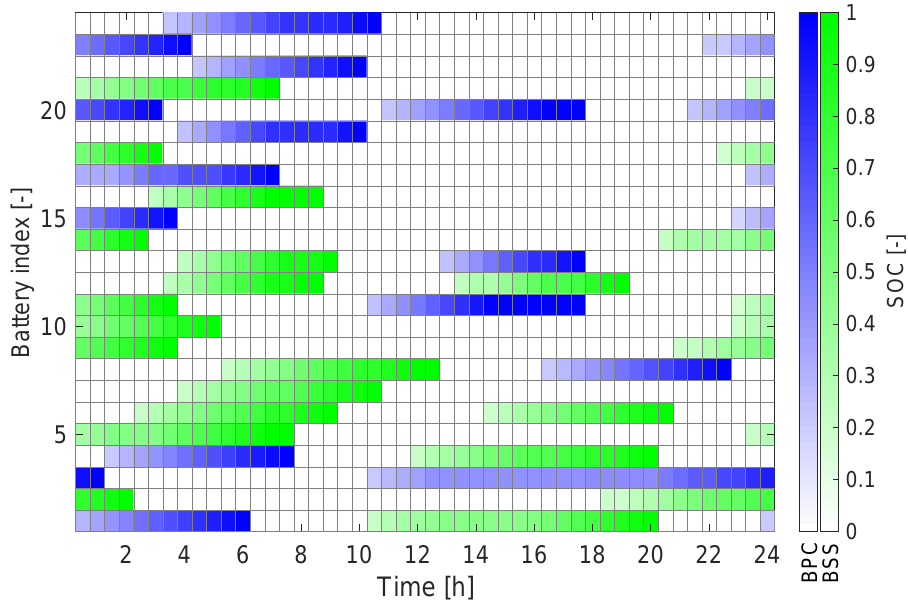
Figure 13. Battery state of charge time evolution at LGAV for the average day case (200 kW